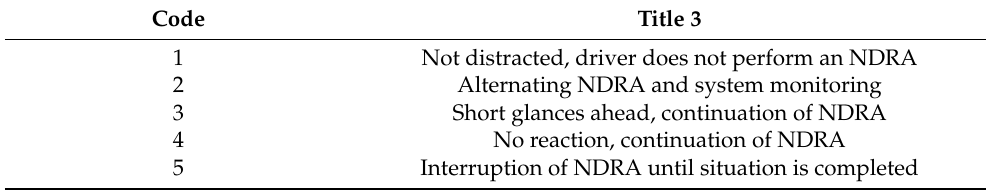
Table 2. Coding scheme for participants’ attentiveness during critical driving and malfunction